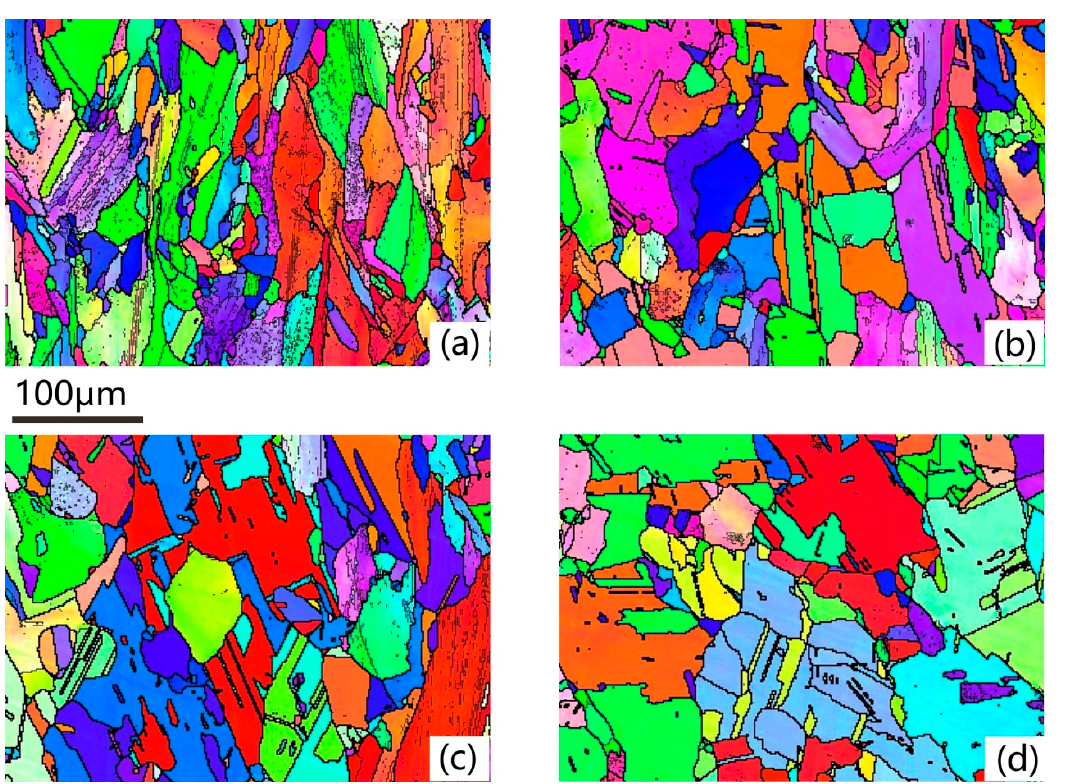
Figure 4. EBSD inverse-pole figure of the samples, ( a ) 1090 ◦ C / h, ( b ) 1100 ◦ C / h, ( c ) 1110 ◦ C / h, ( d ) 1120 ◦ C / h.